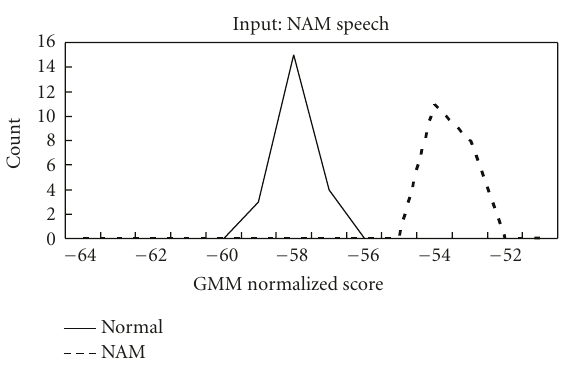
Figure 23: GMM normalized scores—input nonaudible